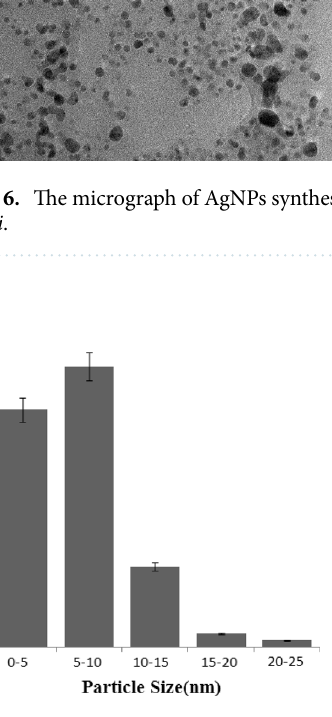
Figure 7. Particle size distribution of AgNPs.